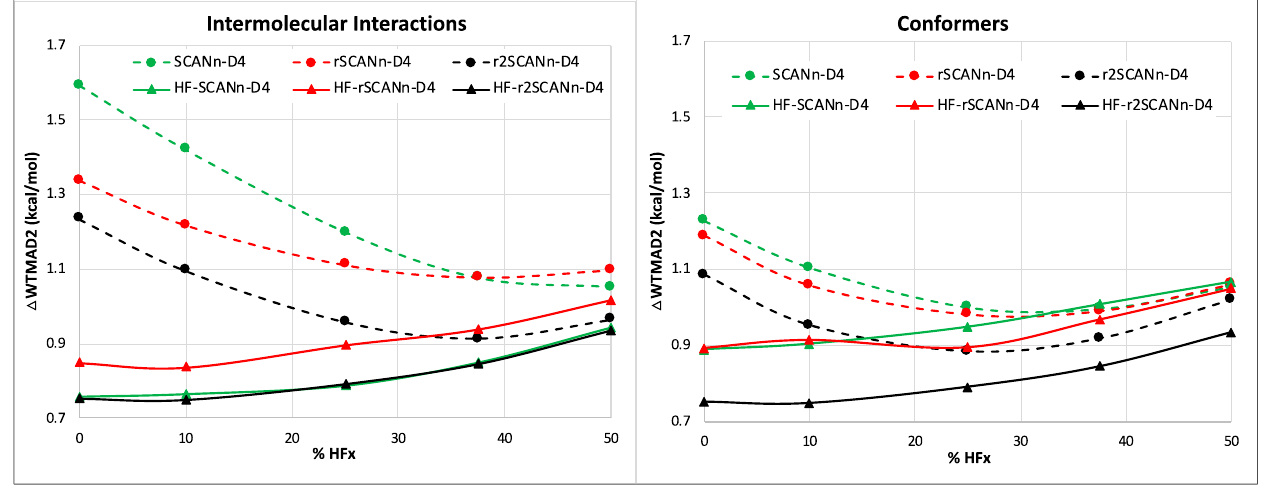
Figure 4. Trend of WTMAD2 contribution ( Δ WTMAD2 in kcal/mol) with respect to the percentage of HF-like exchange for the intermolecular interaction and conformer subsets. The solid lines represent the HF-DFT-D4 series, and the dashed lines are for the corresponding self-consistent series.